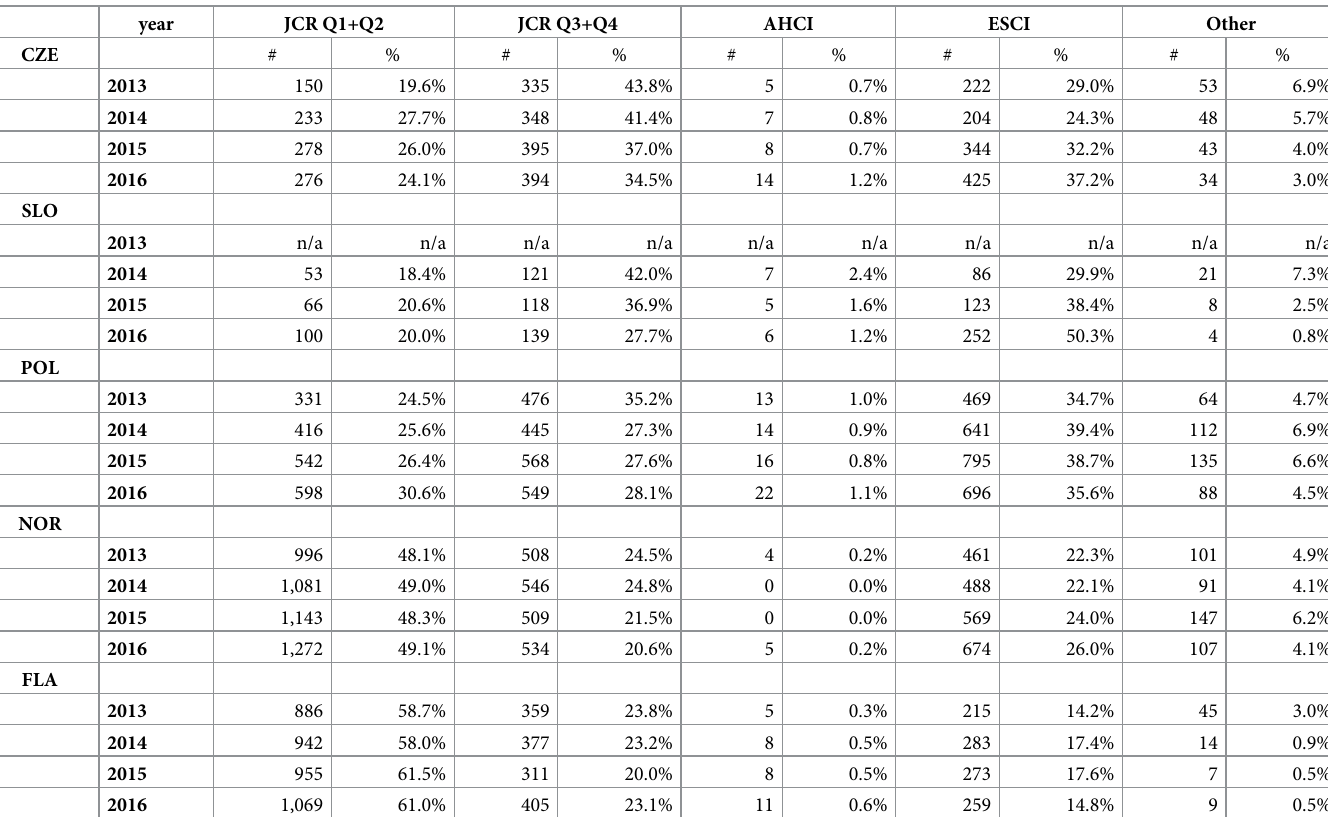
Table 2. Distribution of articles in WoS citation indexes–social